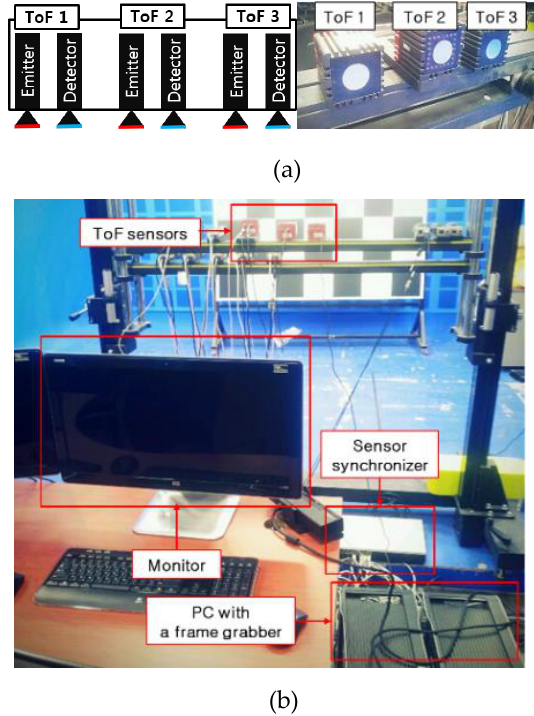
Figure 4. Depth sensor setup. ( a ) Position of the three ToF sensors and ( b ) operation example of ToF sensors.